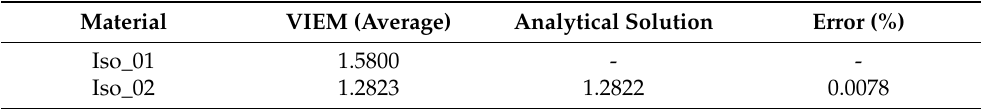
Figure 7. A typical discretized spherical model in the volume integral equation method (VIEM). ( a ) An inside view of a spherical model. ( b ) A spherical model. Table 6. Normalized tensile stress component ( σ xx / σ o xx ) within the isotropic spherical inclusion due to uniform remote tensile loading ( σ o xx ).